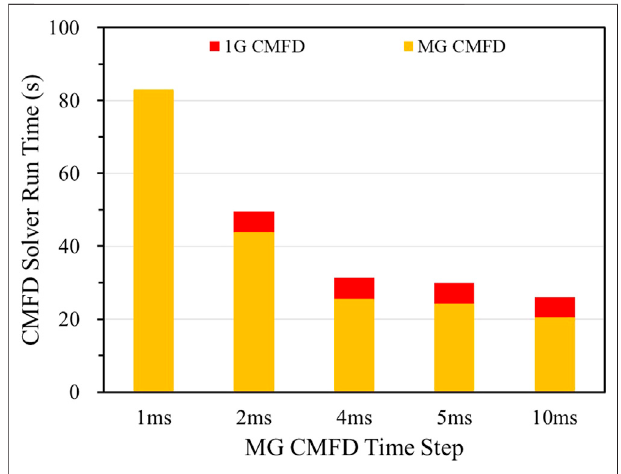
FIGURE 10 | Acceleration performance of AML-PCQM cases on CMFD run time.